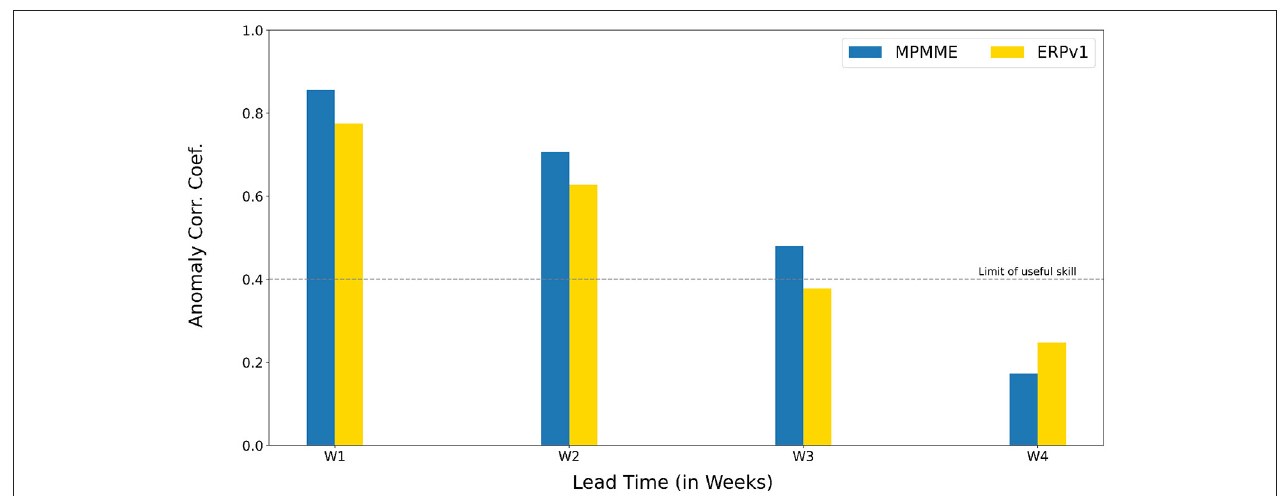
FIGURE 1 | Anomaly correlation coefficient for weekly mean rainfall (mm/day) over Monsoon Zone of India during summer monsoon.